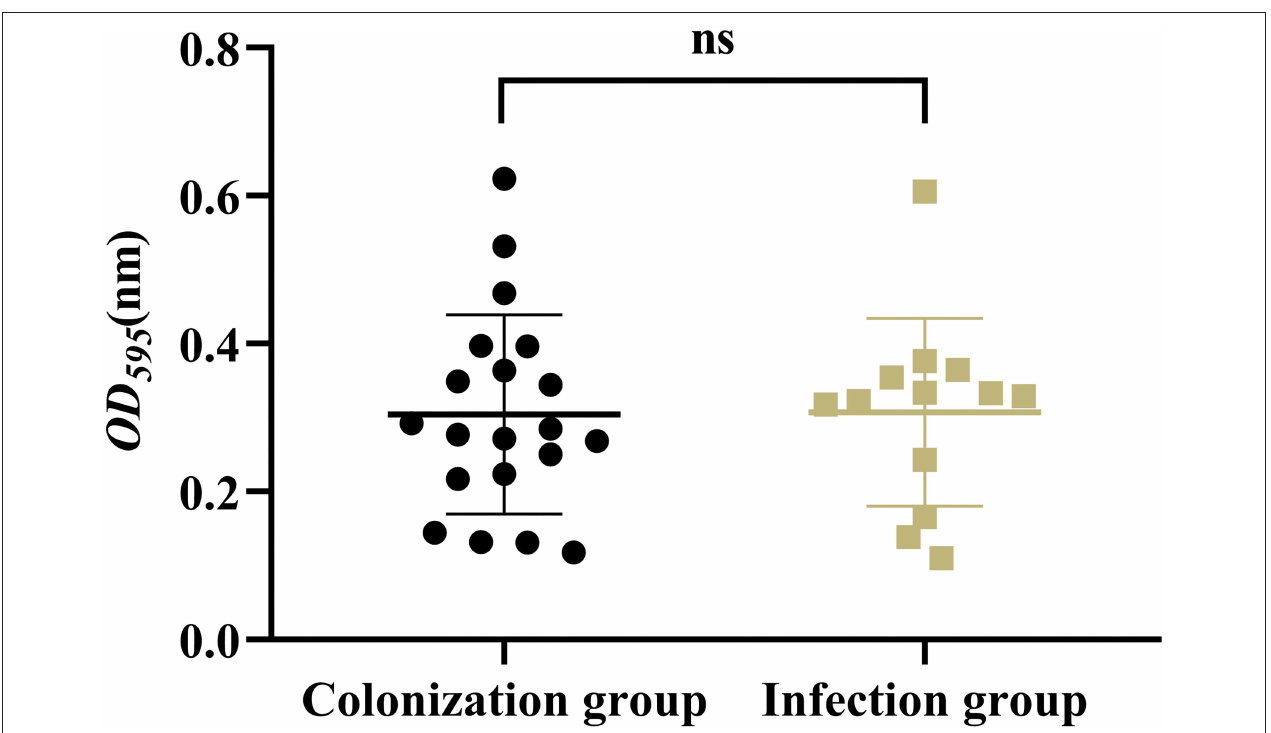
FIGURE 4 | Biofilm-forming ability of intestinal CRKP strains. ns, no significant difference.